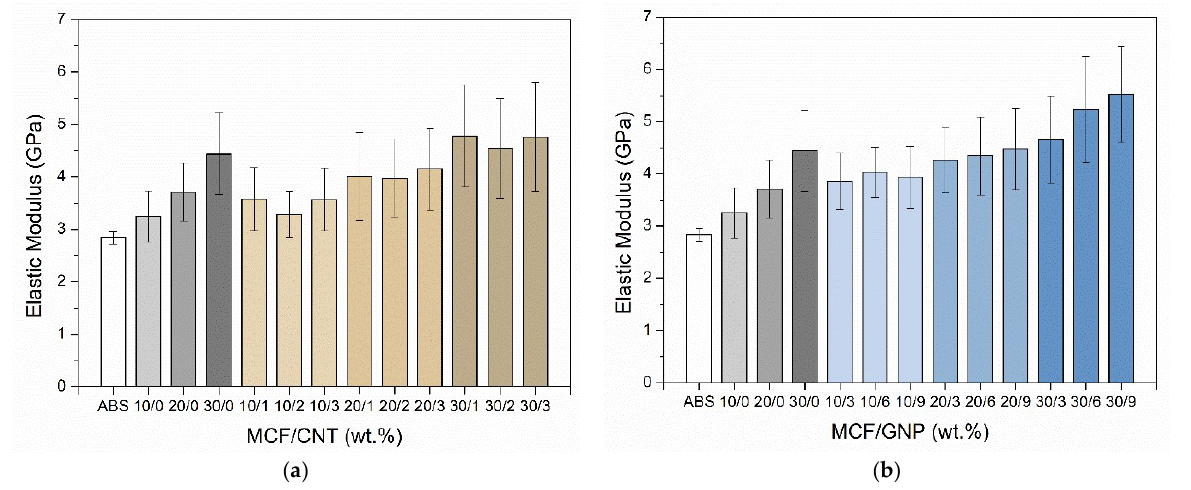
Figure 6. Elastic modulus, En, of CM samples as determined from nanoindentation test at different ( a ) carbon nanotube and ( b ) graphene contents in MCF/CNT and MCF/GNP composites, respectively. The relative ratio of MCF vs. CNT or GNP is reported in percentage by wt.